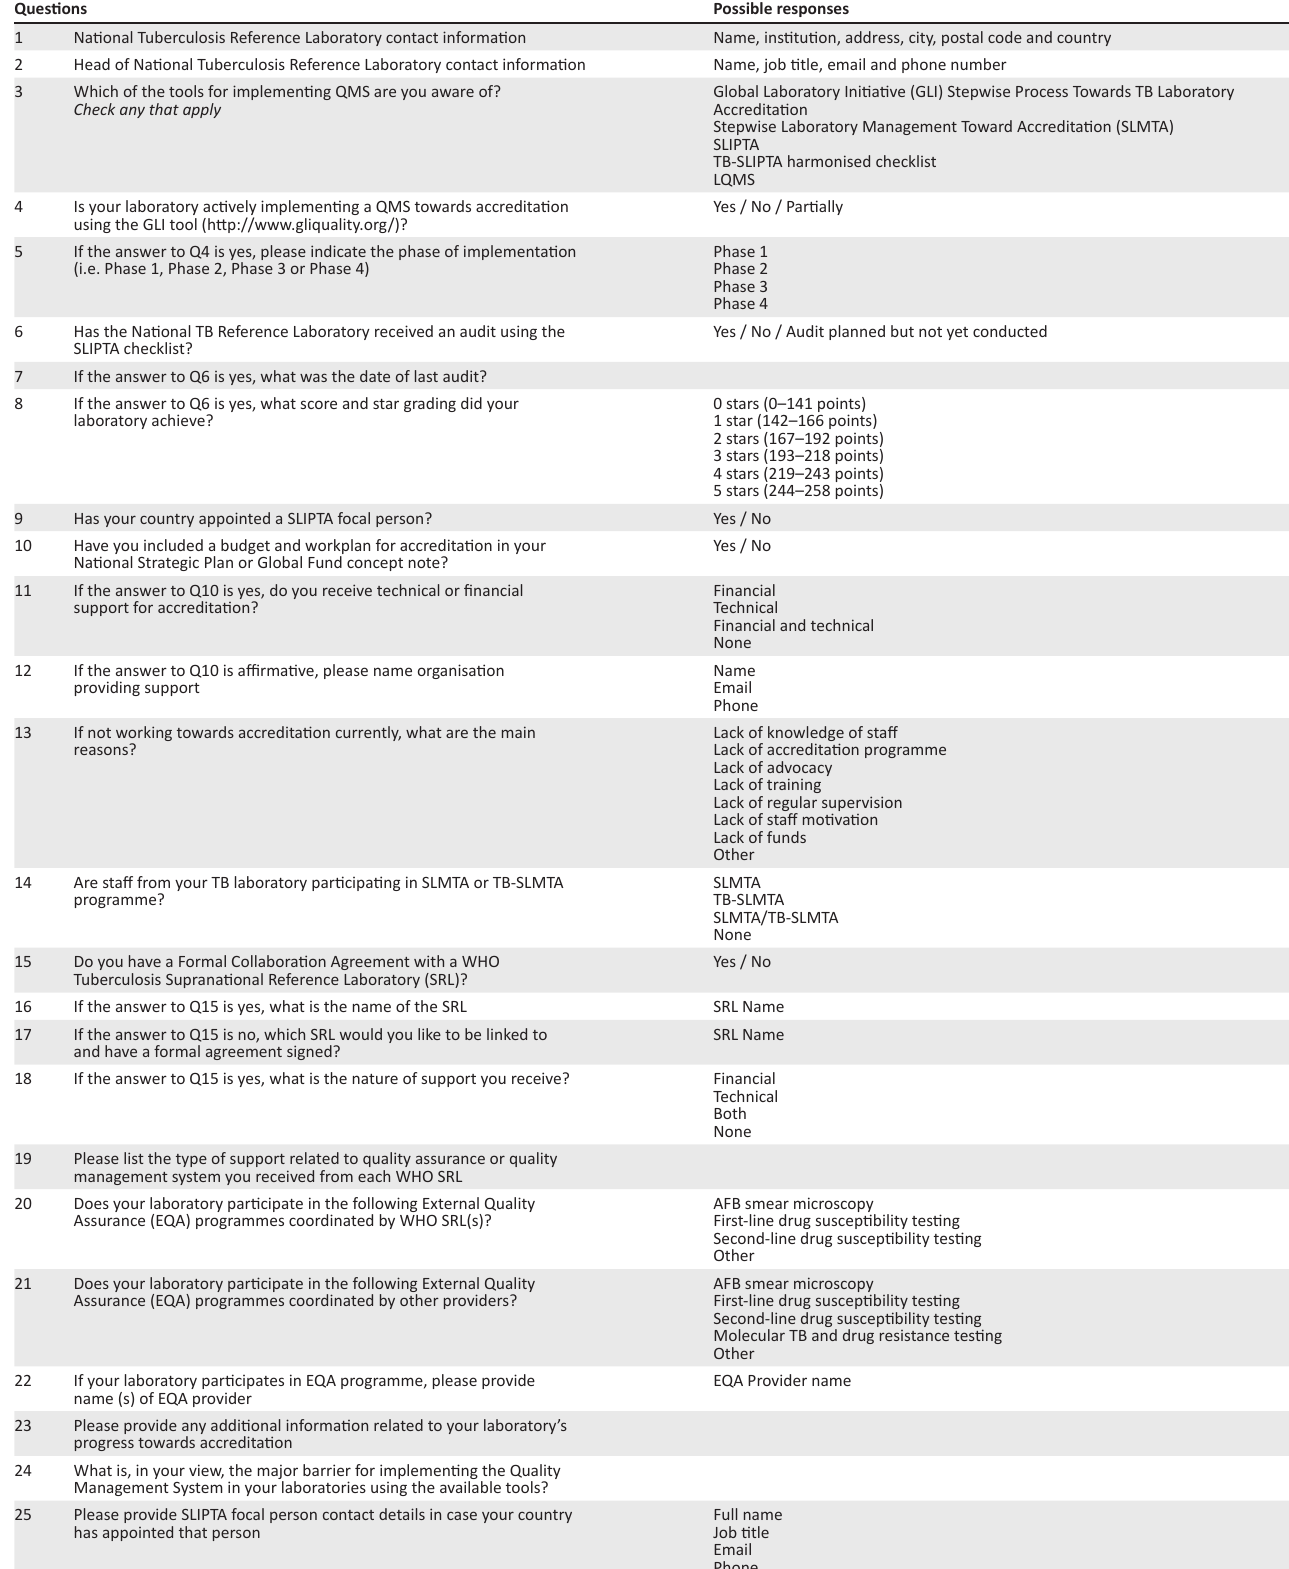
TABLE 1: National Tuberculosis Reference Laboratory Accreditation Preparedness Survey questions Questions Possible